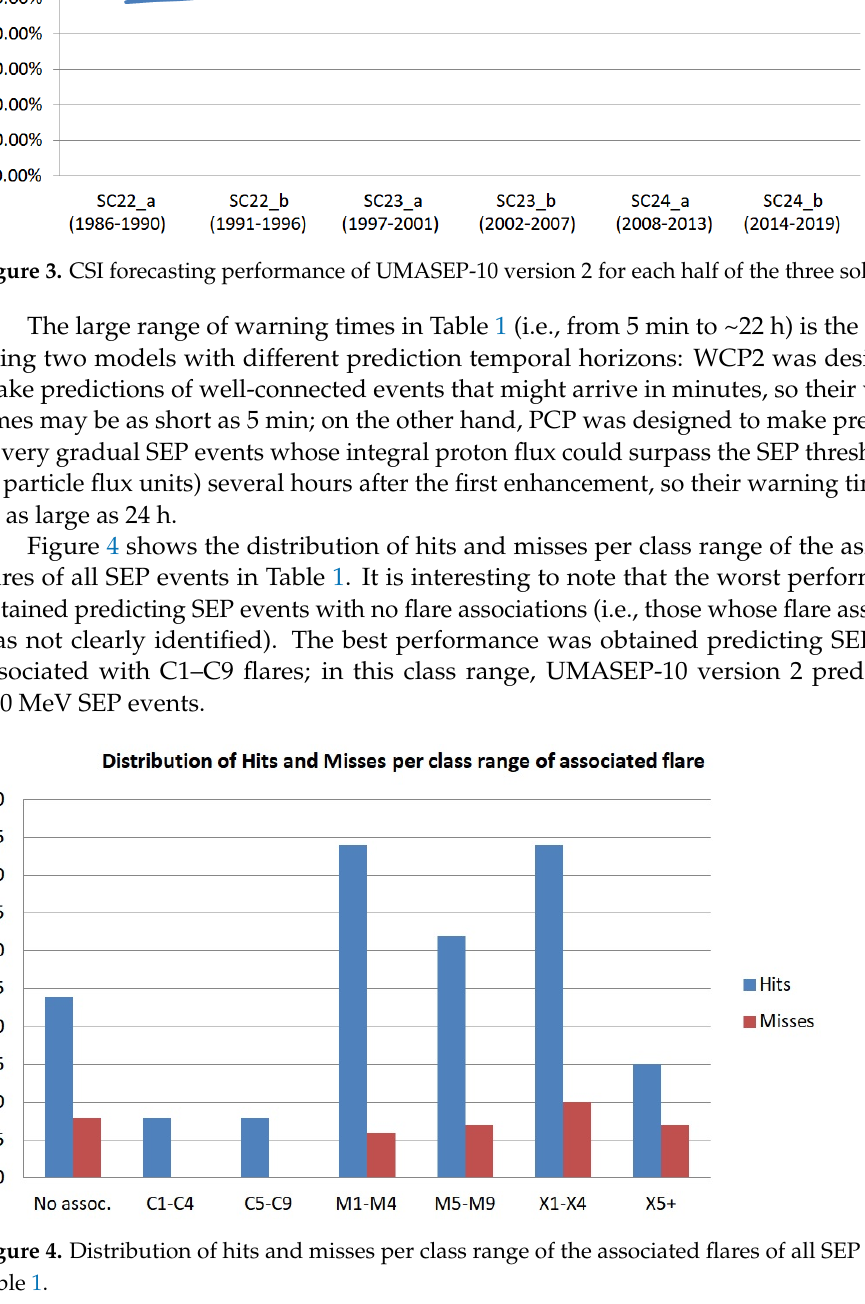
Figure 4. Distribution of hits and misses per class range of the associated flares of all SEP events in Table 1.